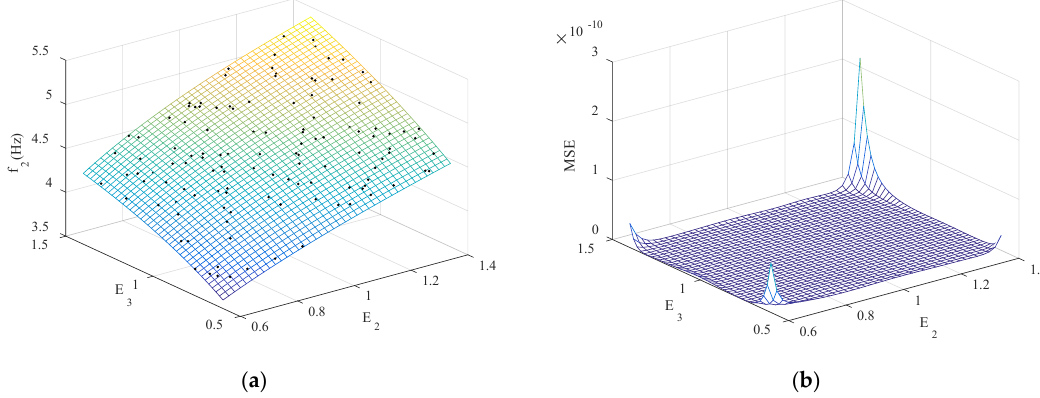
Figure 19. The frequency of f 2 in the function of E 2 and E 3 : ( a ) Kriging model and data samples; ( b ) the corresponding MSE.